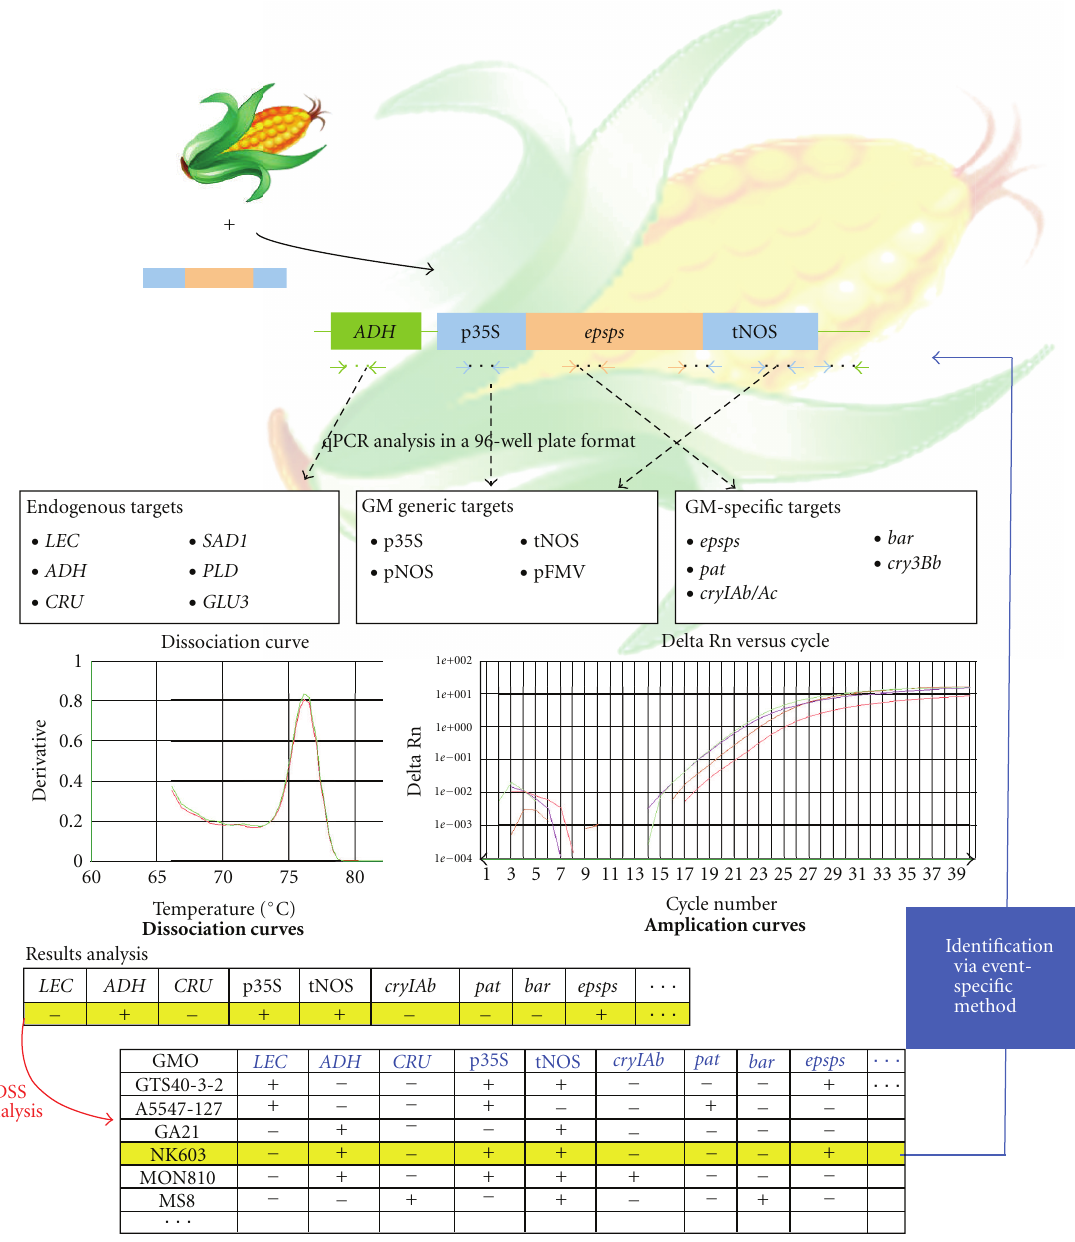
Figure 2: Example of the use of the CoSYPS for the detection of maize GM event NK603 (see text for details on the markers used). The following steps are performed. (1) Real-time PCR screening of the sample with the panel of markers. (2) Introduction of the results (Ct and Tm) in the CoSYPS. (3) The CoSYPS gives a list of GM events possibly present in the sample. (4) Identification of the GM events using the event-specific